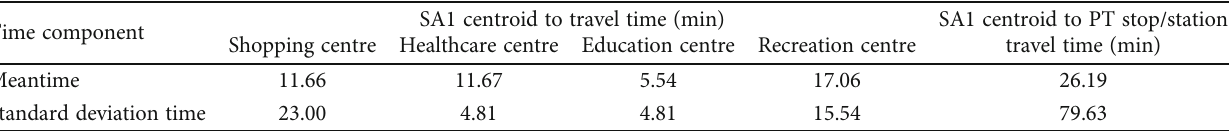
Table 3: Summary statistics of travel time to each category of POI.